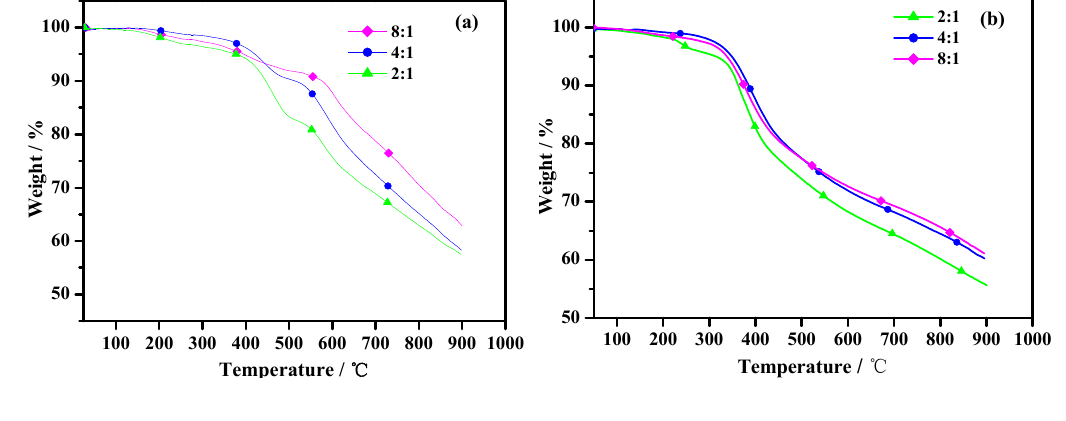
Figure 5. TGA of polymers: ( a ) poly(TT)s; ( b ) poly(TMT)s; [FeCl